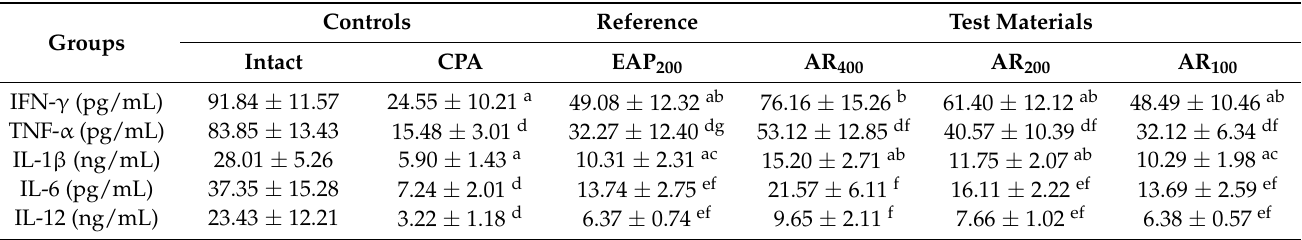
Table 5. Serum cytokine levels in intact and CPA-induced immunosuppressed